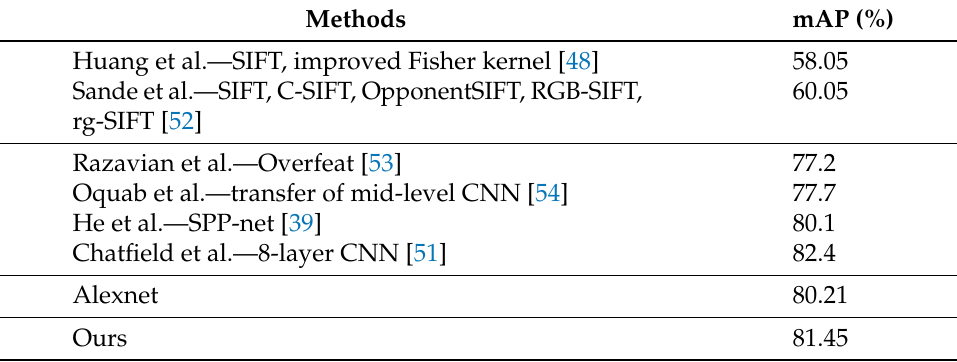
Table 5. Comparison of mAP on Pascal VOC